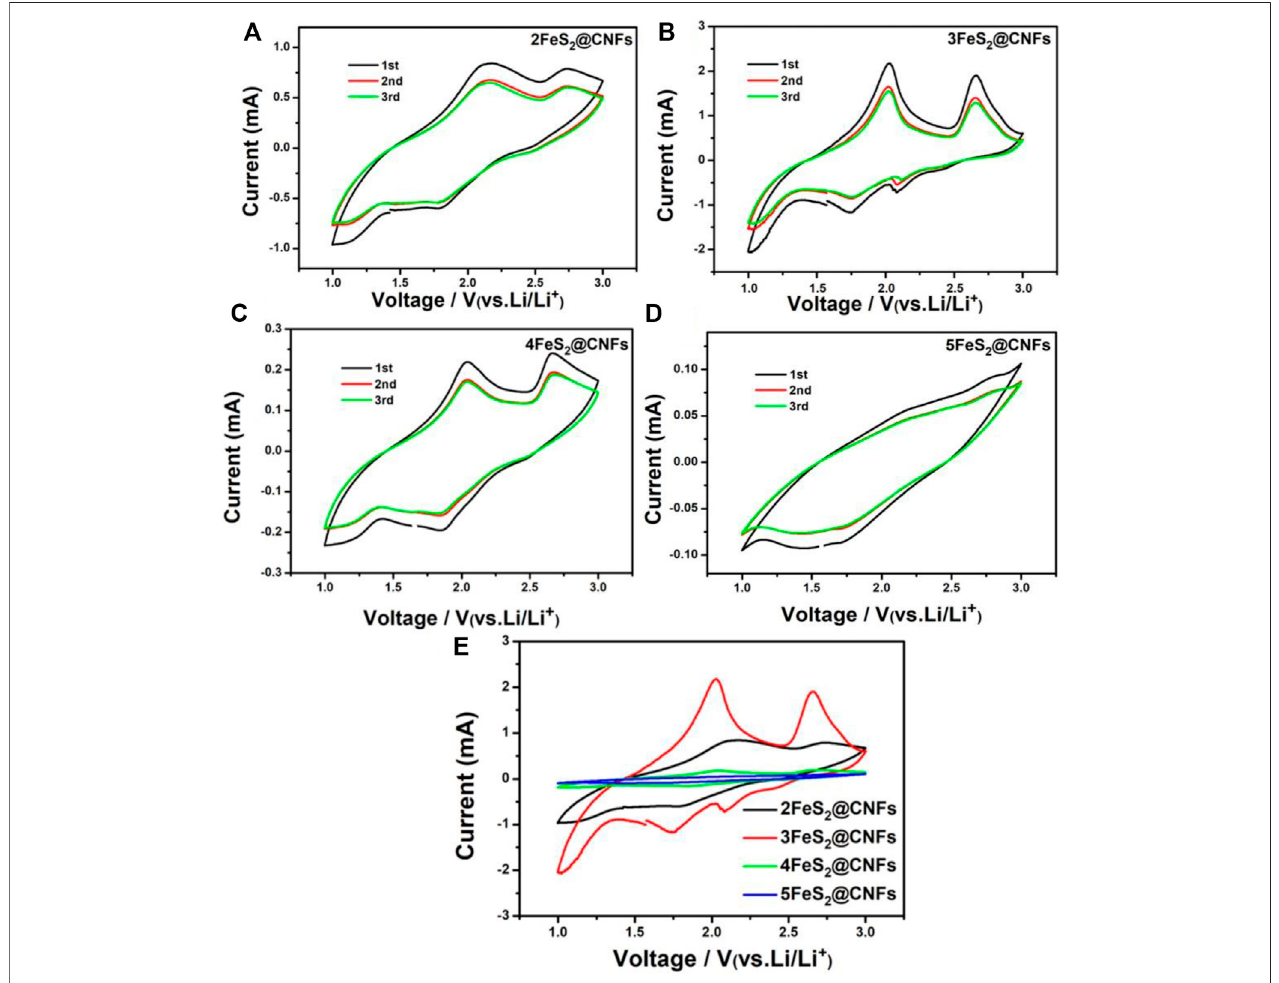
FIGURE 7 | CV curves of (A) 2FeS2@CNFs, (B) 3FeS2@CNFs, (C) 4FeS2@CNFs, and (D) 5FeS2@CNFs in the initial 3 cycles at 0.5 mV s − 1 ; (E) CV curves of the fi rst cycle for different electrodes at 0.5 mV s − 1 .